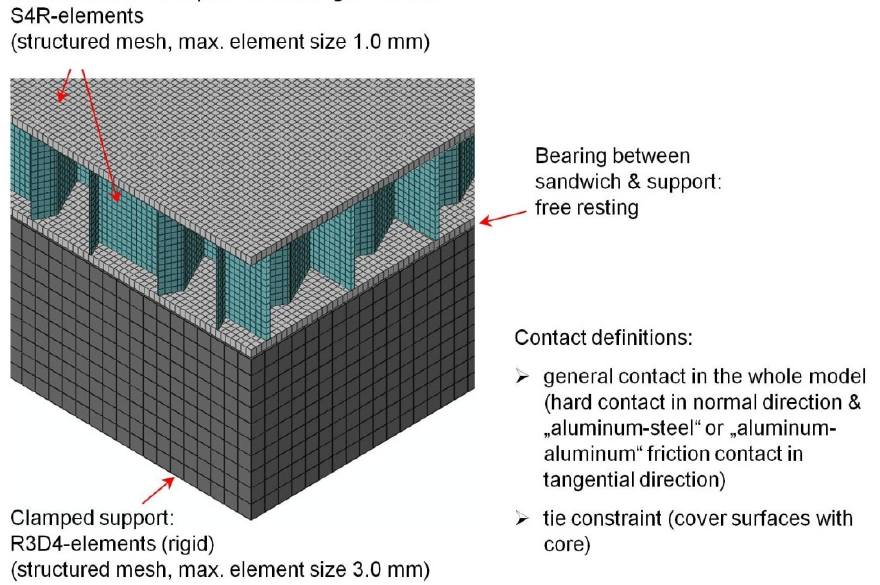
Figure 14. Exemplary presentation of the FE ‐ mesh as well as bearing and contact